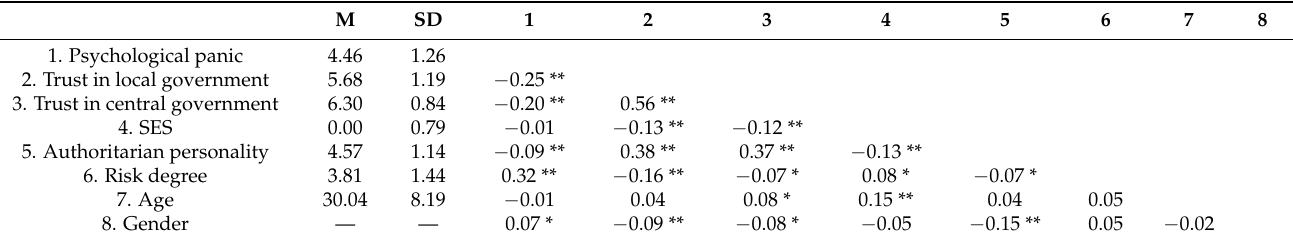
Table 2. Descriptive statistics and correlations about all variables (N = 933).